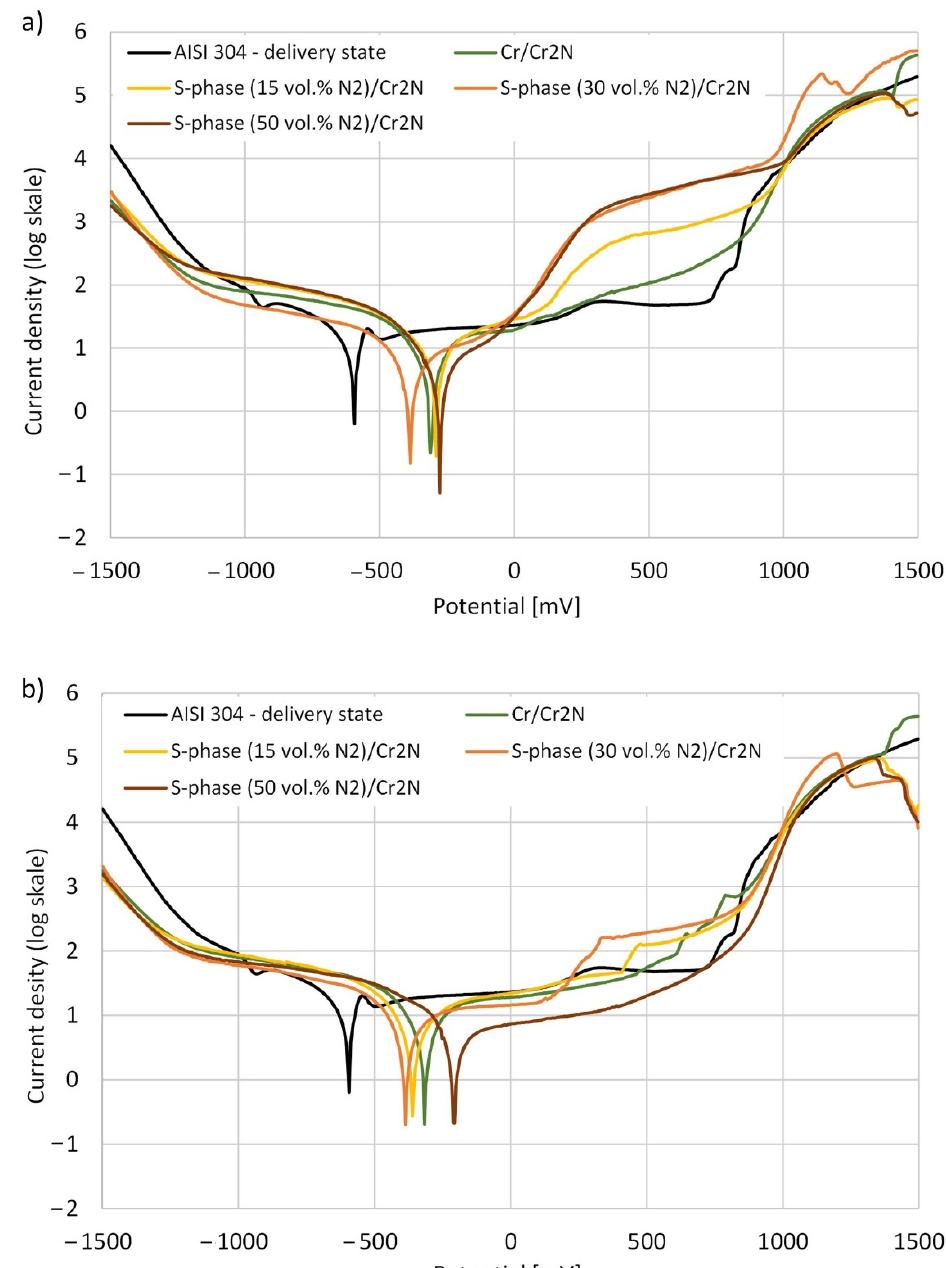
Figure 7. Polarization curves for composite coatings deposited on: ( a ) substrate in as delivery state and ( b ) polished substrate. Table 2. Corrosion potential (E corr ), corrosion current density (i corr ) and polarization resistance (R p ) for investigated coatings.